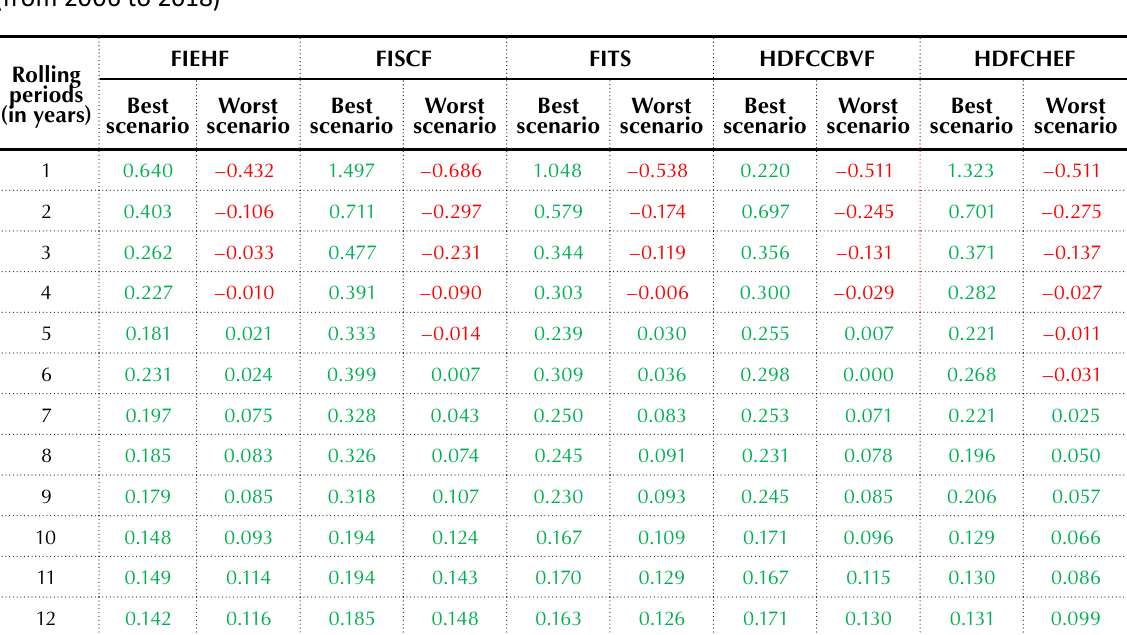
Table 7. Rolling period CAGR (in %) for FIEHF, FISCF, FITS, HDFCCBVF, HDFCHEF